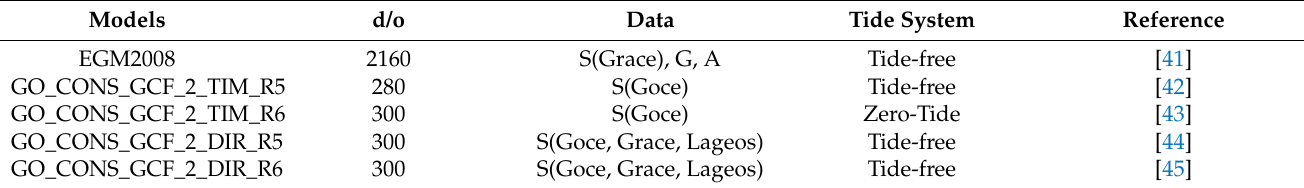
Table 1. The details for global gravity field models. The letter “S” in the third column represents satellite data, “G” represents ground observations, “A” represents altimetry observations, and “d/o” represents